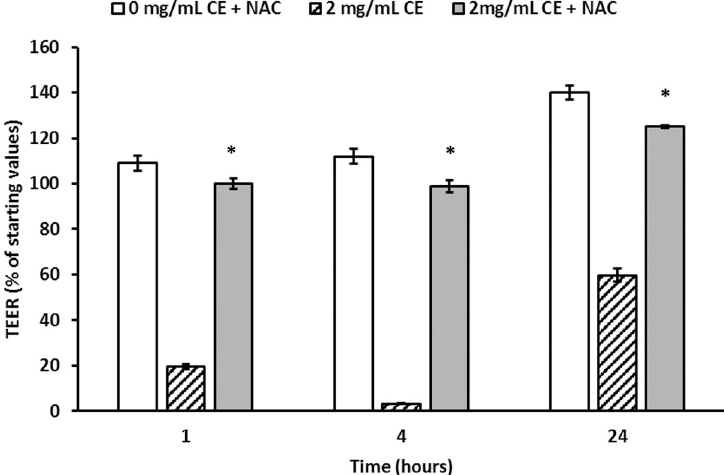
Fig 7. N-acetilcysteine prevents the A . simplex CE-induced TEER decrease. Caco-2 cell monolayers were incubated with the antioxidant N-acetylcysteine (NAC; 4mM) for 1 hour. Thereafter, cells were exposed to 2mg/mL A . simplex CE in the presence of 4mM NAC and TEER was measured at 1, 4 and 24 hours. The results are expressed as mean ± SD. The asterisks indicate significant differences between absence and presence of NAC 1hour (P < 0.001, 95% CI = -74.6—-69.3), 4 hours (P < 0.001, 95%CI = -88.0—-81.8) and 24 hours (P = 0.002. 95%CI = -30.8—-12.8). https://doi.org/10.1371/journal.pntd.0008462.g007 ZO-1 and occludin showed typical cellular staining. At two hours of incubation with CE, TJ rings became broken. Changes were more extensive for occludin, which was barely detected. In x–z sections, the pattern of ZO-1 appears as a broken and thicker staining line while occlu- din is not observed. After 24 hours of incubation with CE, the normal distribution of TJ pro- teins was partially recovered (Fig 8).